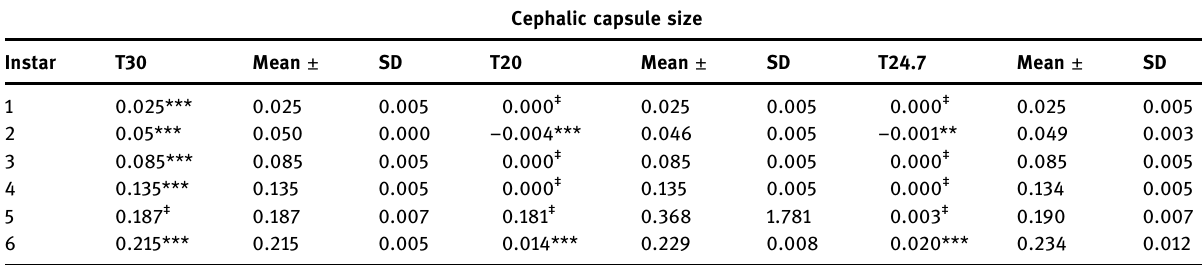
Table 2: Size ( mm ) of the cephalic capsule of D. busckella at di ff erent temperatures under controlled conditions Cephalic capsule size